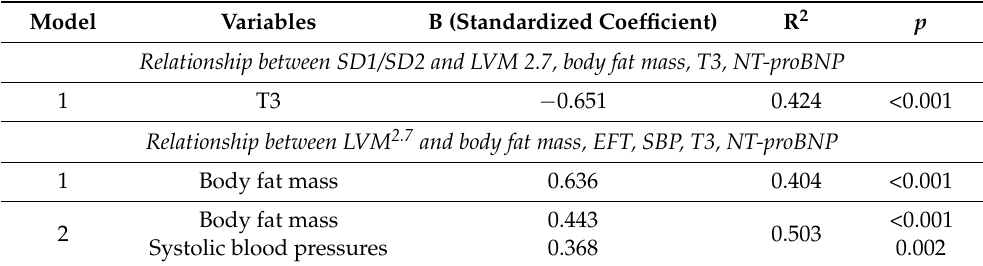
Table 3. Multivariate stepwise